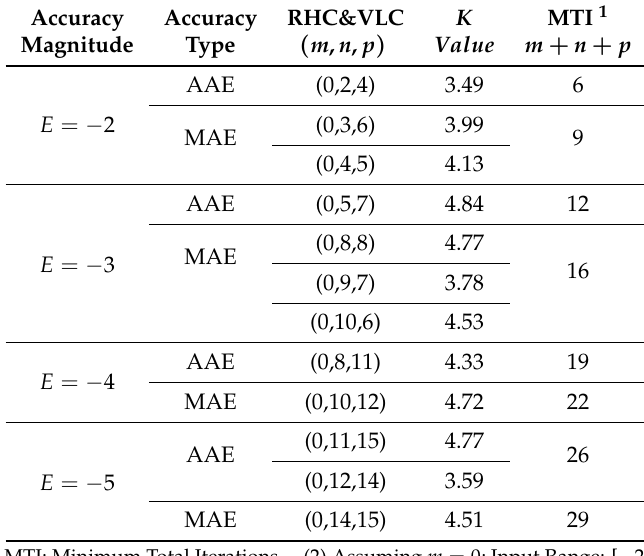
Table 3. Sigmoid: Relationship Between the Magnitudes of Accuracy and Iterations. Accuracy